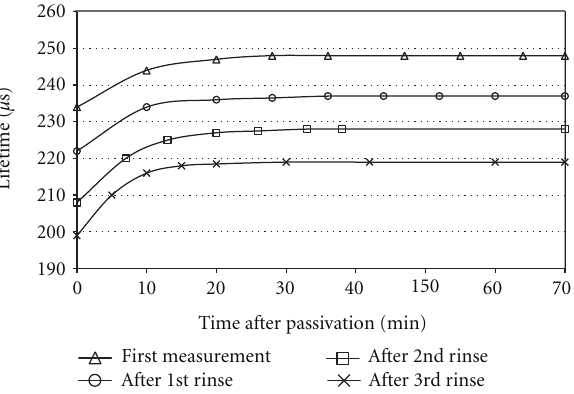
Figure 6: Three cycles of passivation-cleaning process (passivated in